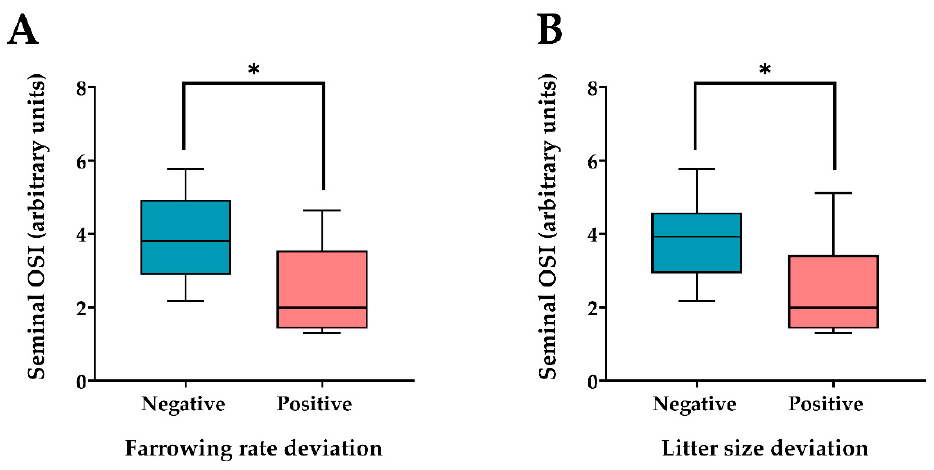
Figure 4. Box-whisker plot showing oxidative stress index (OSI) values assessed in the seminal plasma of ejaculates collected from artificial insemination boars hierarchically ( p < 0.001) grouped as showing ( A ) negative (ranging from − 2.79 to − 0.16; n = 8) or positive (ranging from +0.94 to +4.54; n = 10) farrowing rate deviations and ( B ) negative (ranging from − 0.43 to − 0.05; n = 8) or positive (ranging from +0.01 to +0.83; n = 10) litter size deviations. Boxes enclose the 25th and 75th percentiles, the line indicates the median and the whiskers extend to the 5th and 95th percentiles. * Indicates significant differences ( p < 0.05) in seminal OSI values between groups.